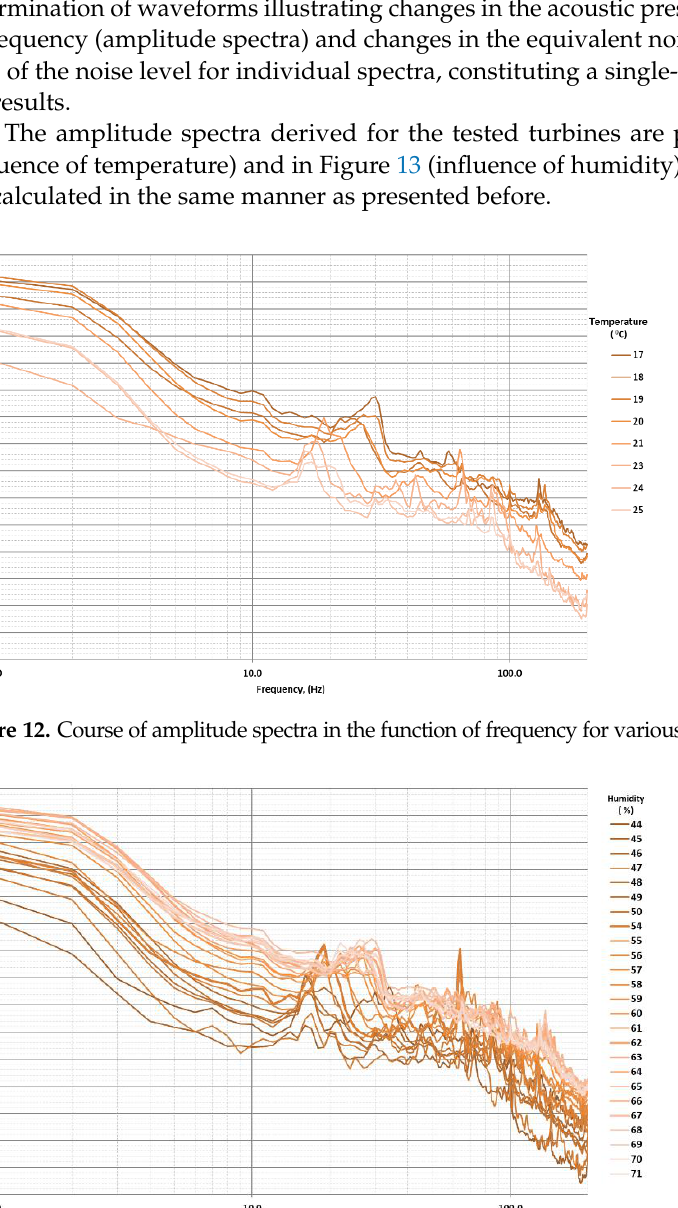
Figure 13. Courses of amplitude spectra representing noise levels in the function of frequency for various air humidity—T2 turbine.